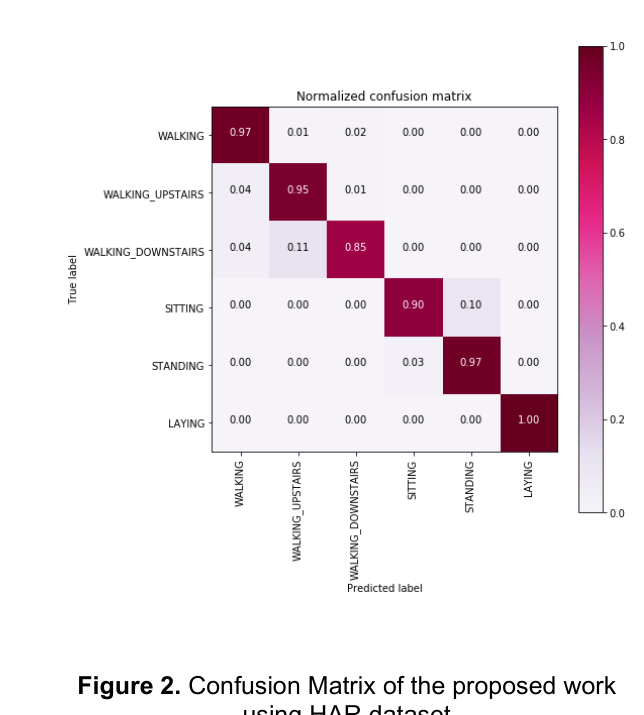
Figure 2. Confusion Matrix of the proposed work using HAR dataset